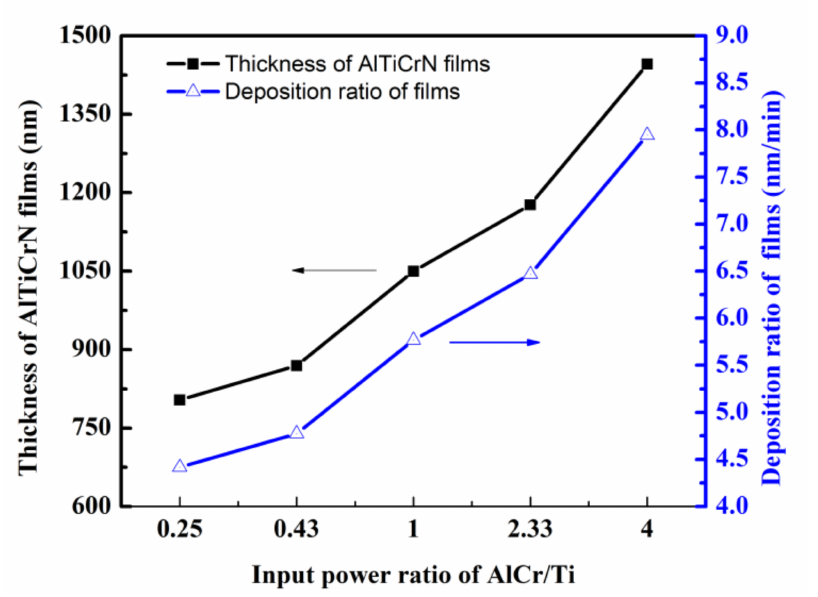
Figure 5. Thickness and deposition ratios of the AlTiCrN coatings as a function of various input power